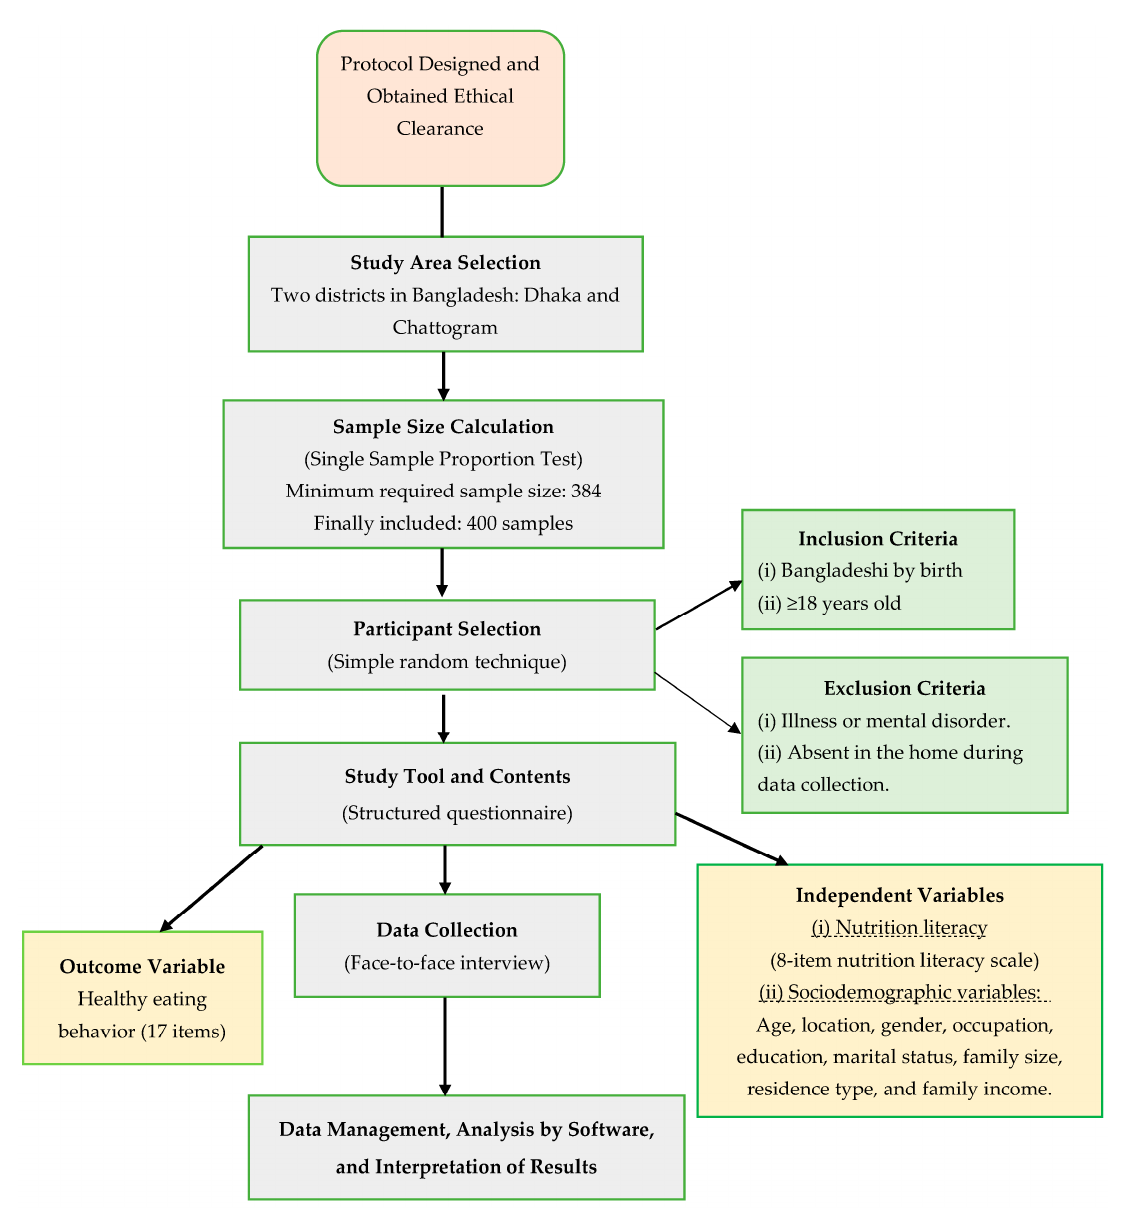
Figure 1. Methodological framework of the